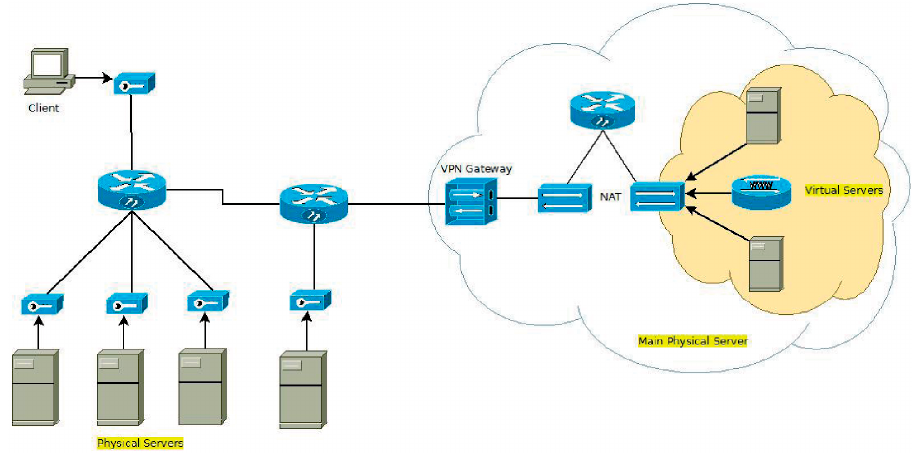
Figure 6. System environment. Table 1. Hardware in the cluster of the experimental environment.